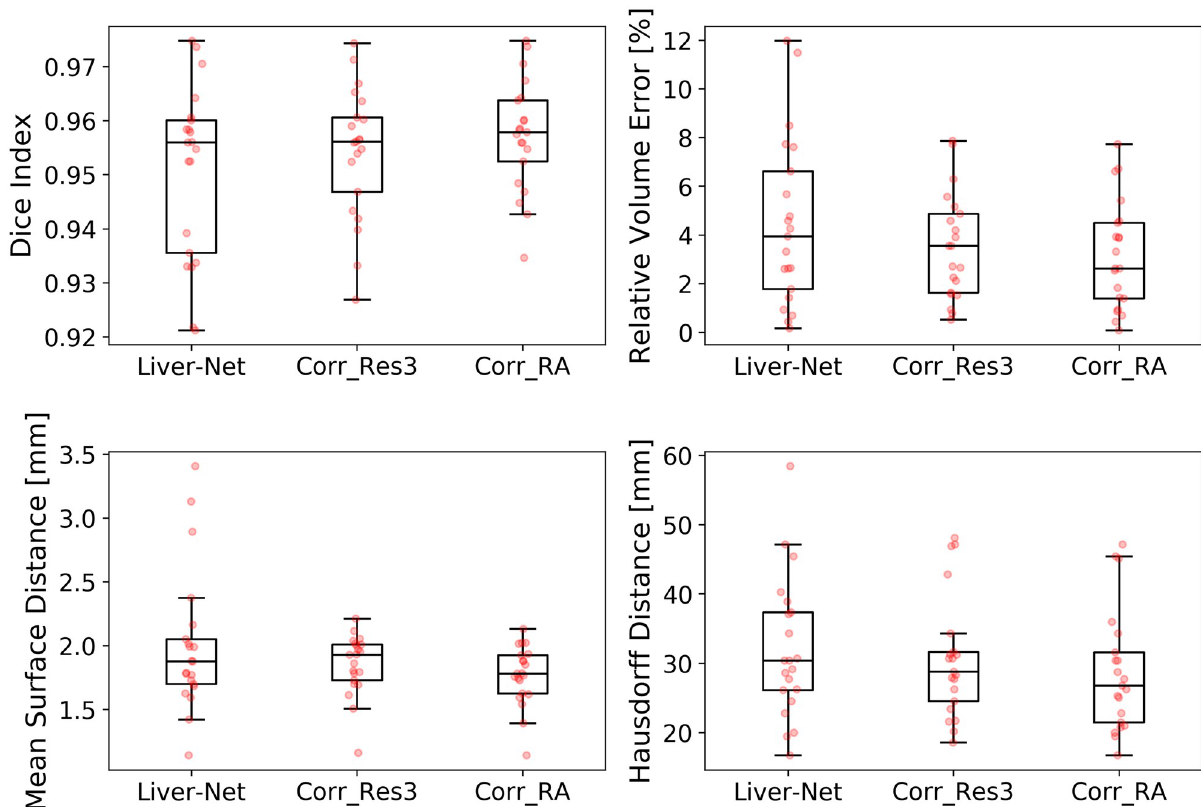
Fig 5. Box plots showing segmentation quality of the Liver-Net masks and their corrections done by Res3 and RA.